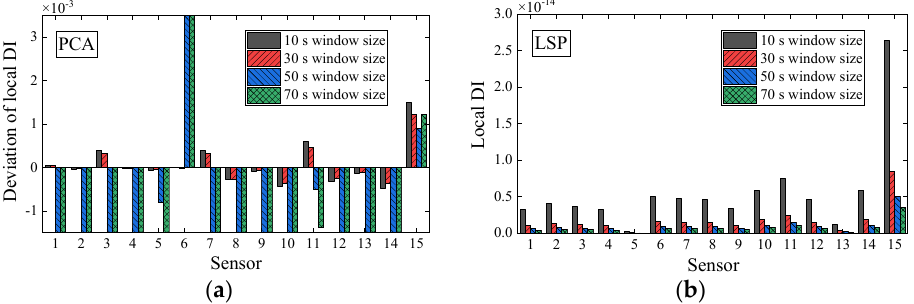
Figure 14. Deviations of local damage indicators corresponding to WPES-based ( a ) PCA and ( b ) LSP methods, respectively, when the second damage (2nd DS) occurs (i.e., 221 s).